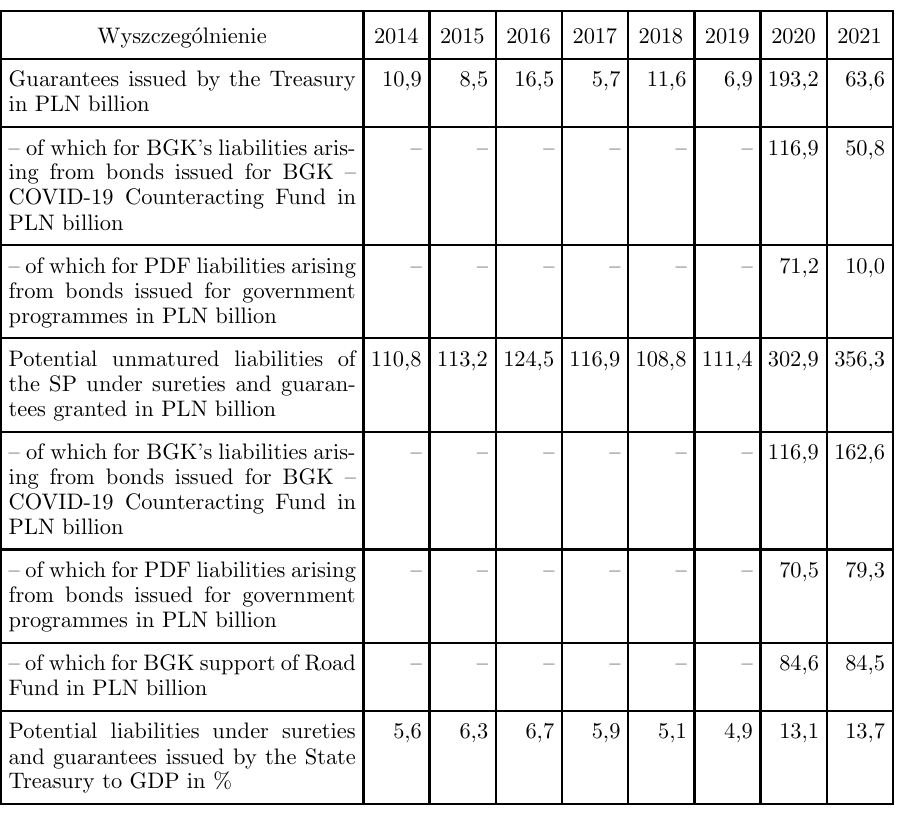
Guarantees and warranties granted by the Treasury between 2014 and